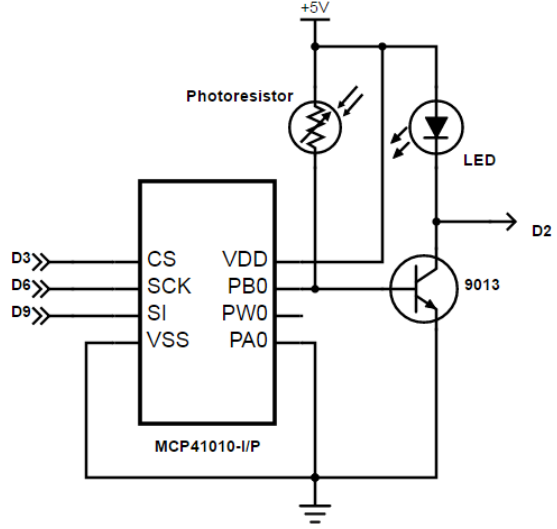
Figure 4. The photosensitive resistor divider.